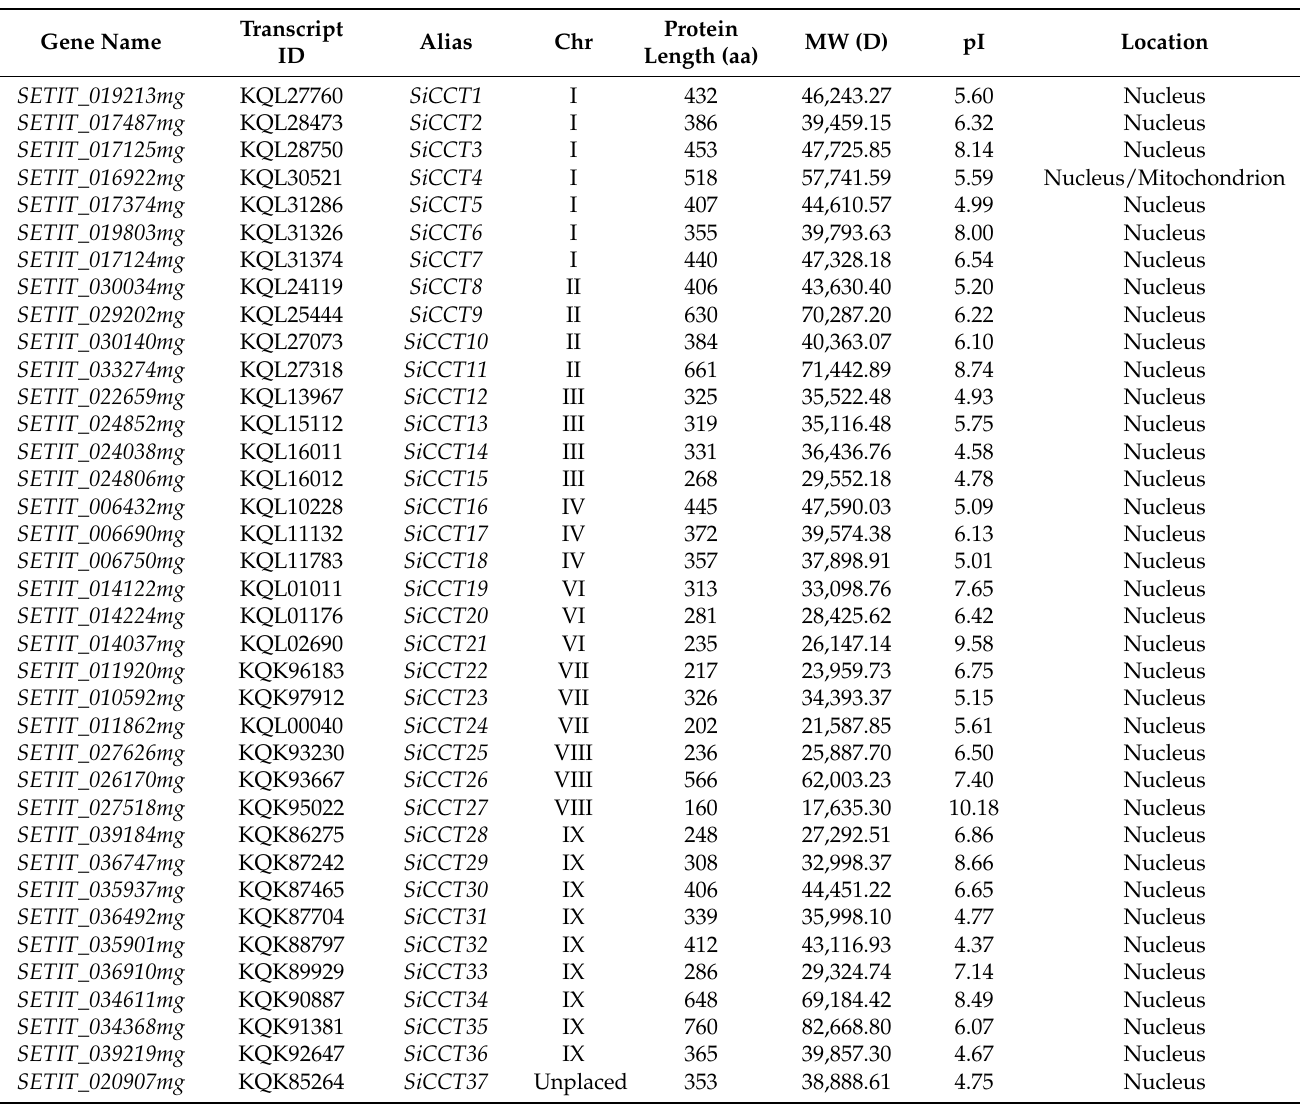
Table 1. List of SiCCT genes identified in this study.